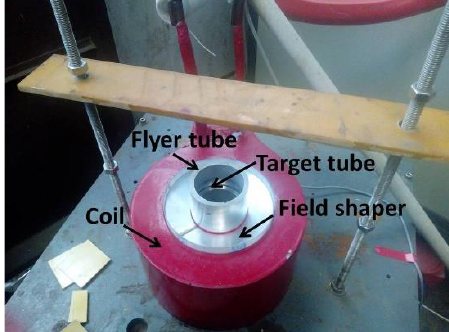
Figure 1. MPW setup for tubular configuration.